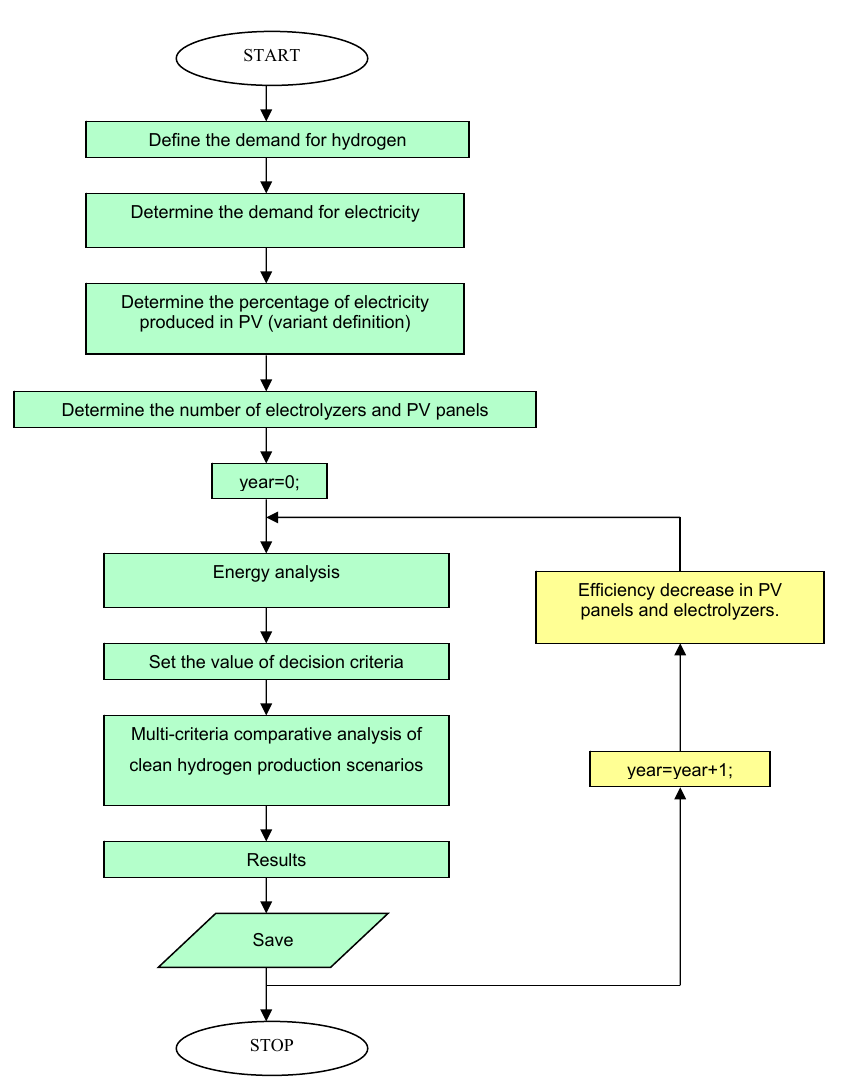
Figure 10. Block diagram of the model used to compare hydrogen production scenarios—own